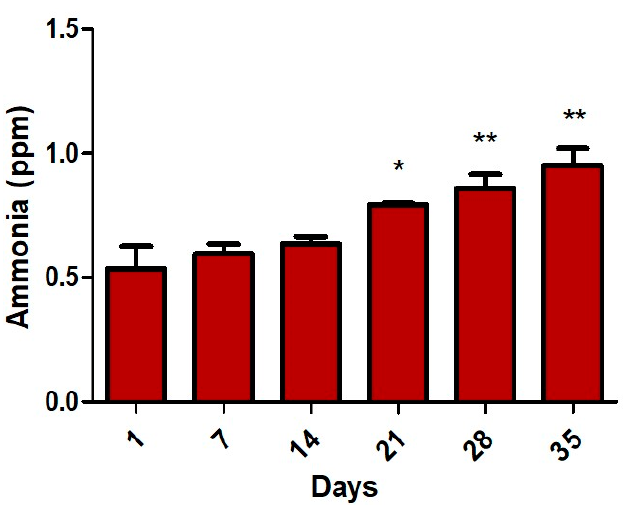
Figure 6. Ammonia concentrations emitted from “Golden Delicious” apples over 35 days under normal conditions. * p < 0.05, ** p < 0.01 for unpaired t- test with Welch’s correction.